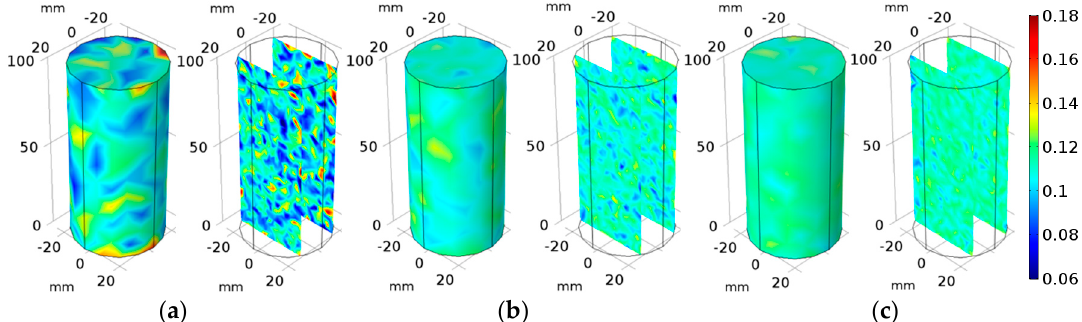
k = 2; ( b ) k = 5; ( c ) w w